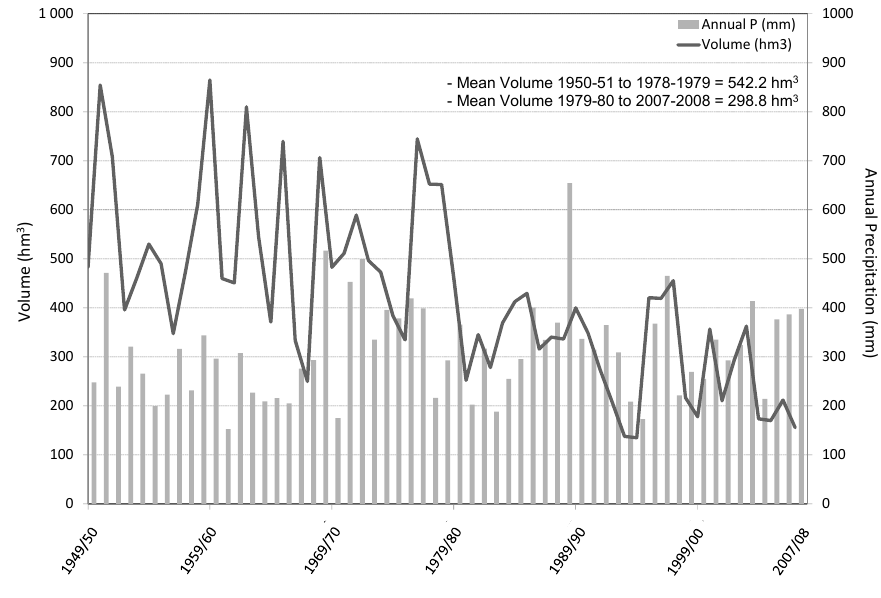
Figure 2. Interannual accumulated runoff (in hm 3 ) of the whole SRB, for the hydrological years 1949–1950 to